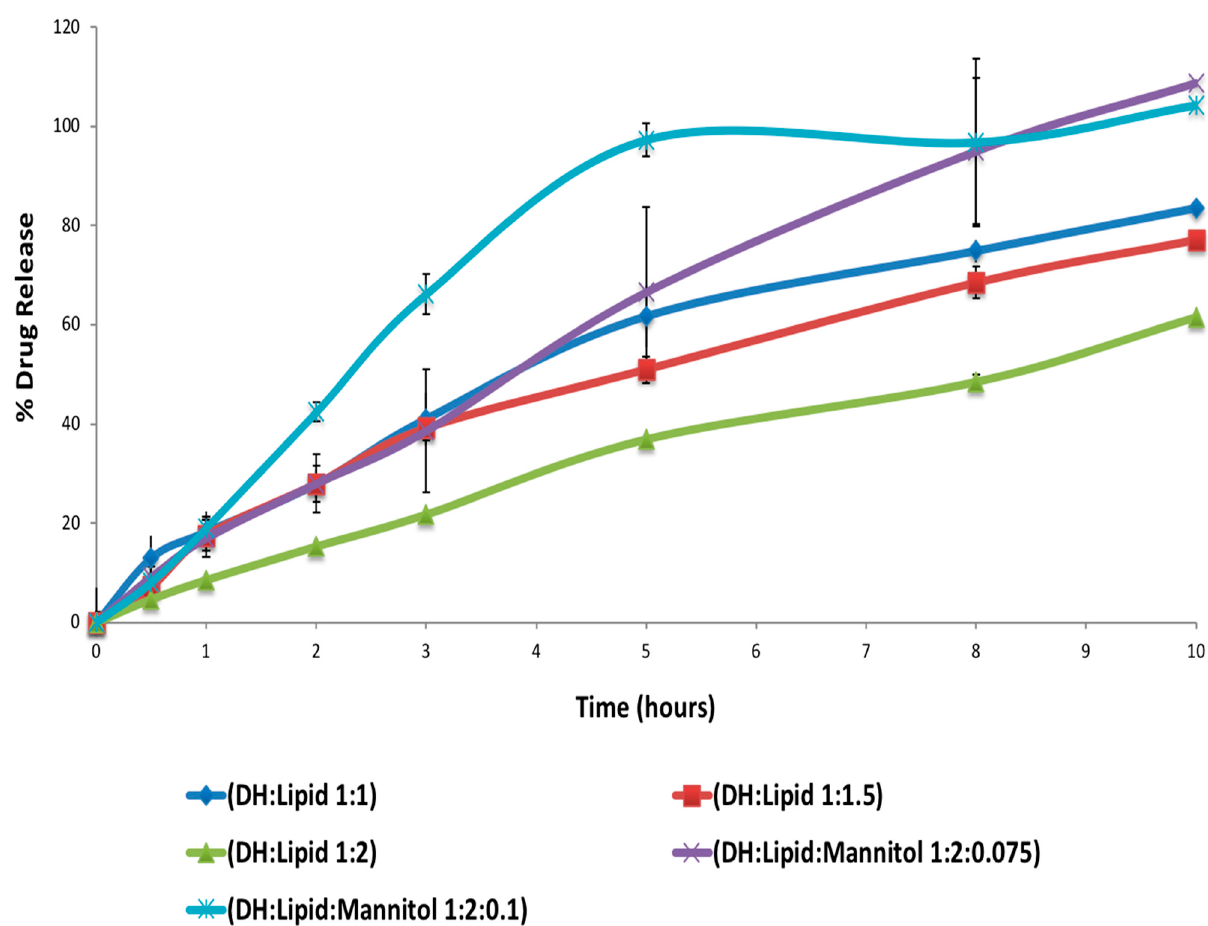
Figure 7. In vitro drug release of DH (mean ± SD; n = 3).